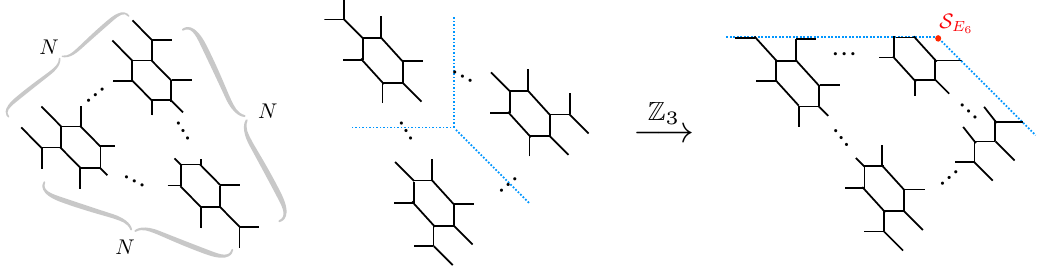
Figure 14 . A 5-brane web of T N theory and Z 3 quotient of the T 3 k